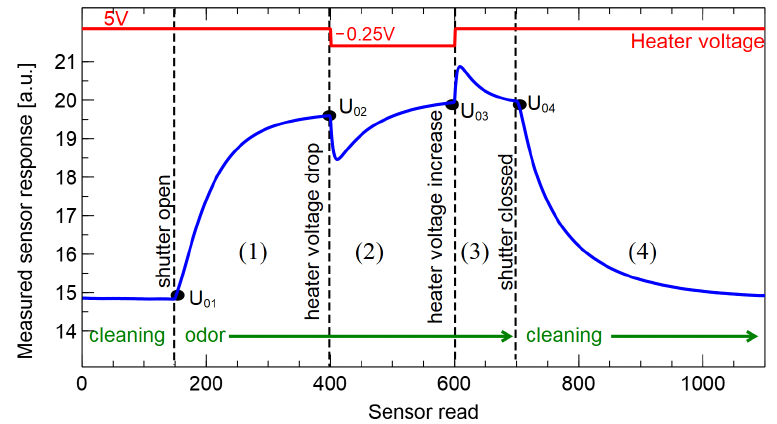
Figure 4. Schematic visualization of the mode of electronic nose operation during one measurement cycle. The measured sensor response is expressed as arbitrary units, as it is the raw output from ADC converter of voltage read on a resistor [32–34,48]. Characteristic moments of measurement procedure as opening/closing of the sensor chamber shutter and heater voltage modulation moments are indicated by vertical lines. Four stages of signal observation time (1)–(4), and characteristic baseline voltages of these stages U 01 –U 04 are marked. The X-axis represents consecutive reads of sensor response magnitude, every 0.75 s. In the example, a response of the TGS 2620 sensor is